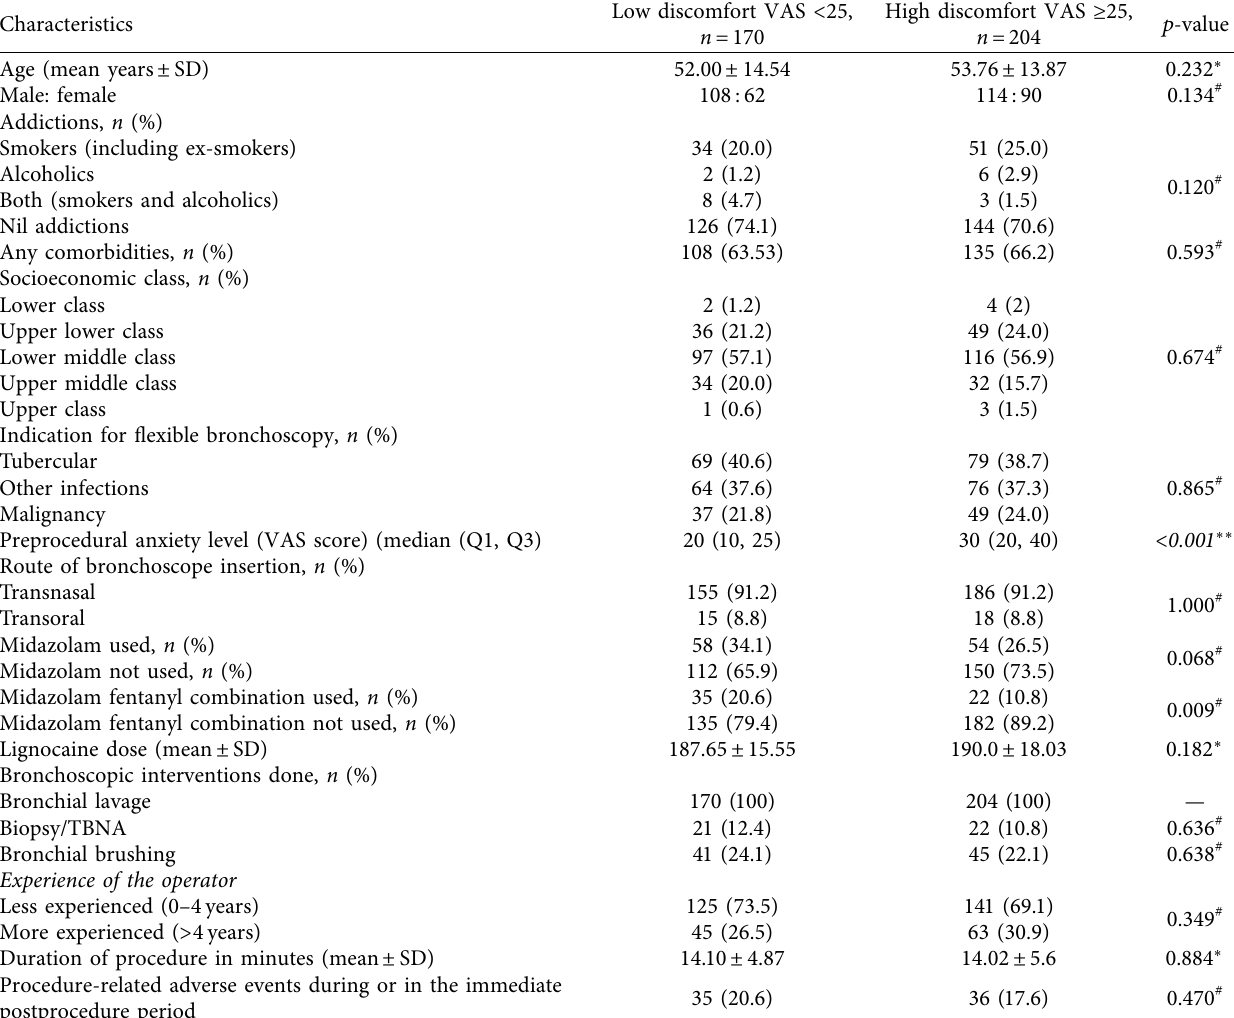
Table 3: Factors affecting patient comfort during flexible